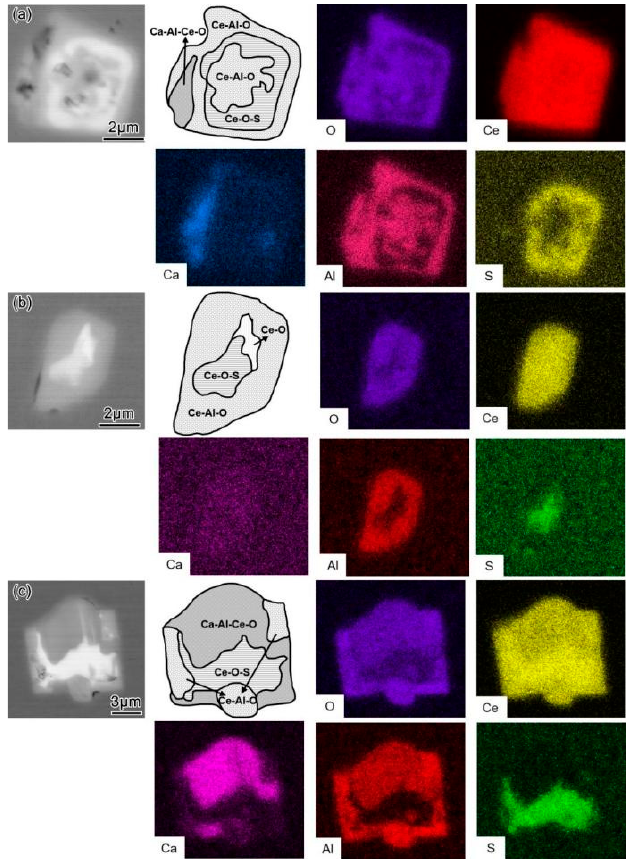
Figure 8. Typical inclusion morphology in ingots after steel solidification (T4): ( a ) L–Ce; ( b ) M–Ce; ( c ) H–Ce.